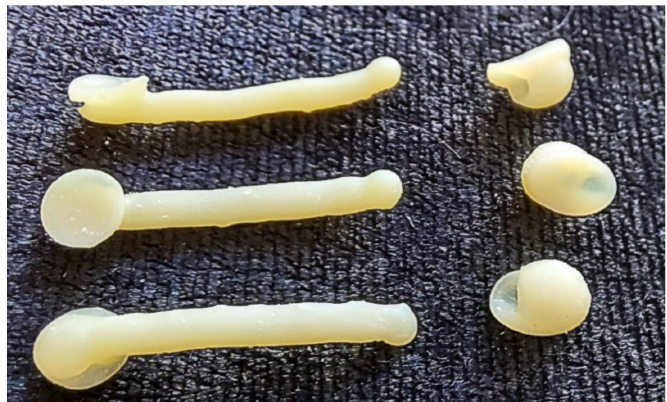
Materials 2022 , 15 , x FOR PEER REVIEW 19 of 29 Figure 14. Three clones of a 3D printed distalizer from material Denture Teeth, shade A2.